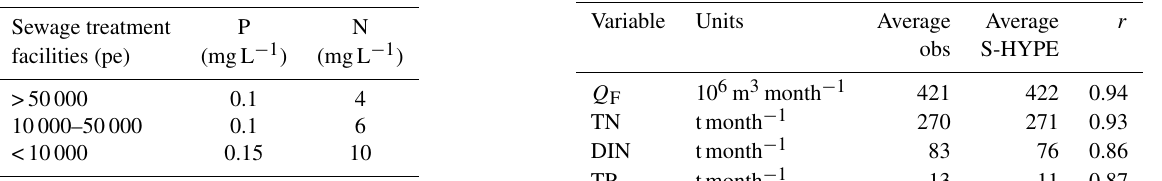
Table 3. The correlation coefficients ( r ) between observations (obs) and model results (S-HYPE), and the long-term (1990–2012) aver- ages of river outflow ( Q F ) and nutrient loads from Lake